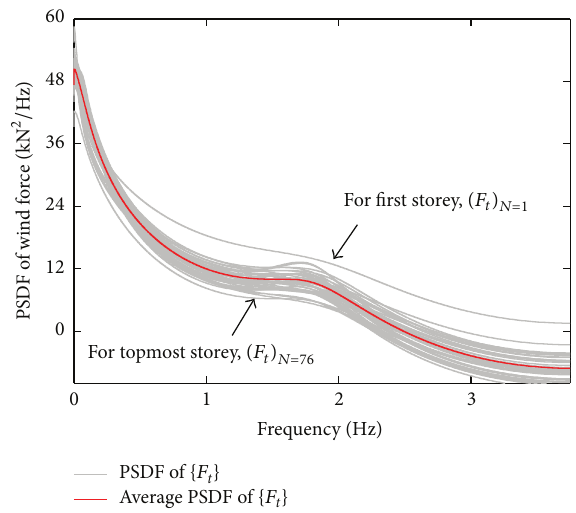
Figure 2: The PSDF of the wind forces applied on